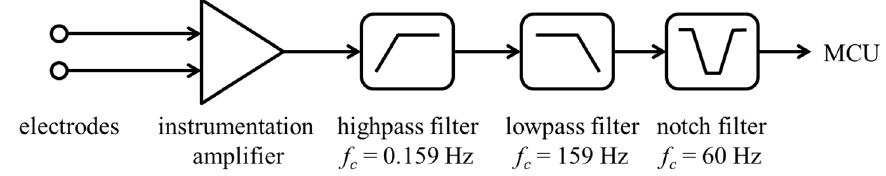
Figure 8. Block diagram of the ECG sensor.